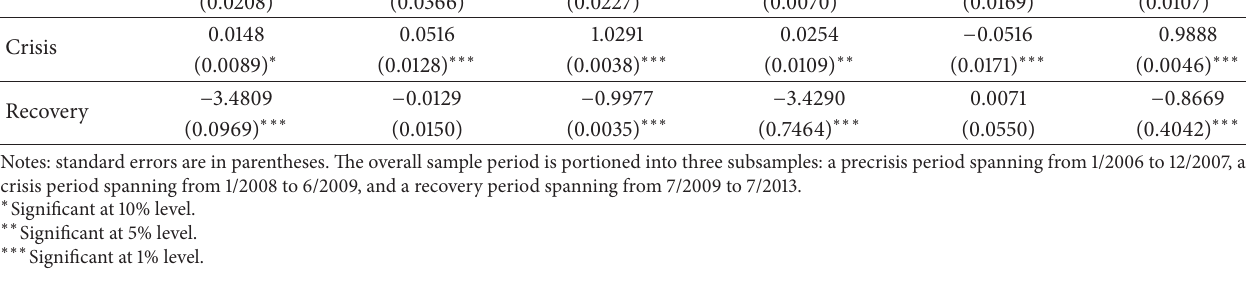
Table 6: Financial contagion analysis between US and